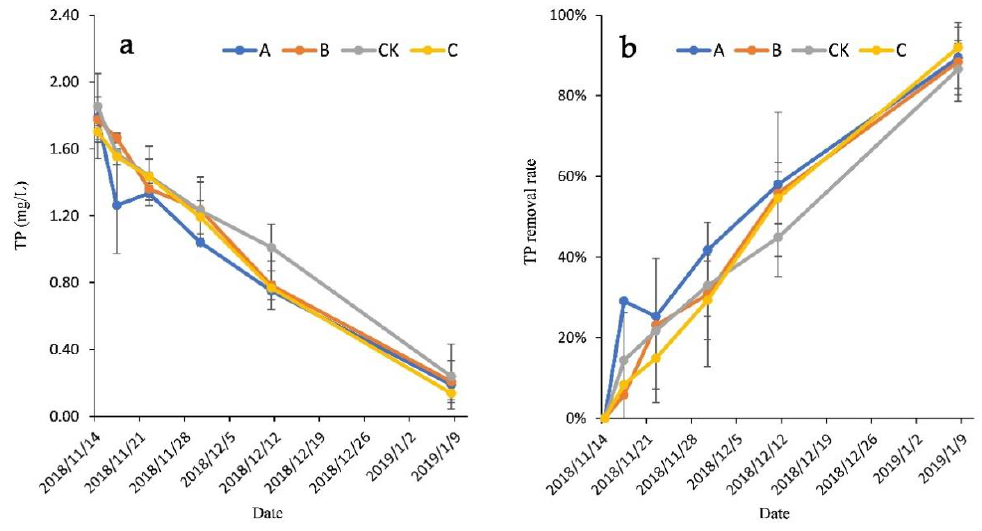
Figure 3. Variation in the ( a ) TP concentration and ( b ) removal rate of each treatment.